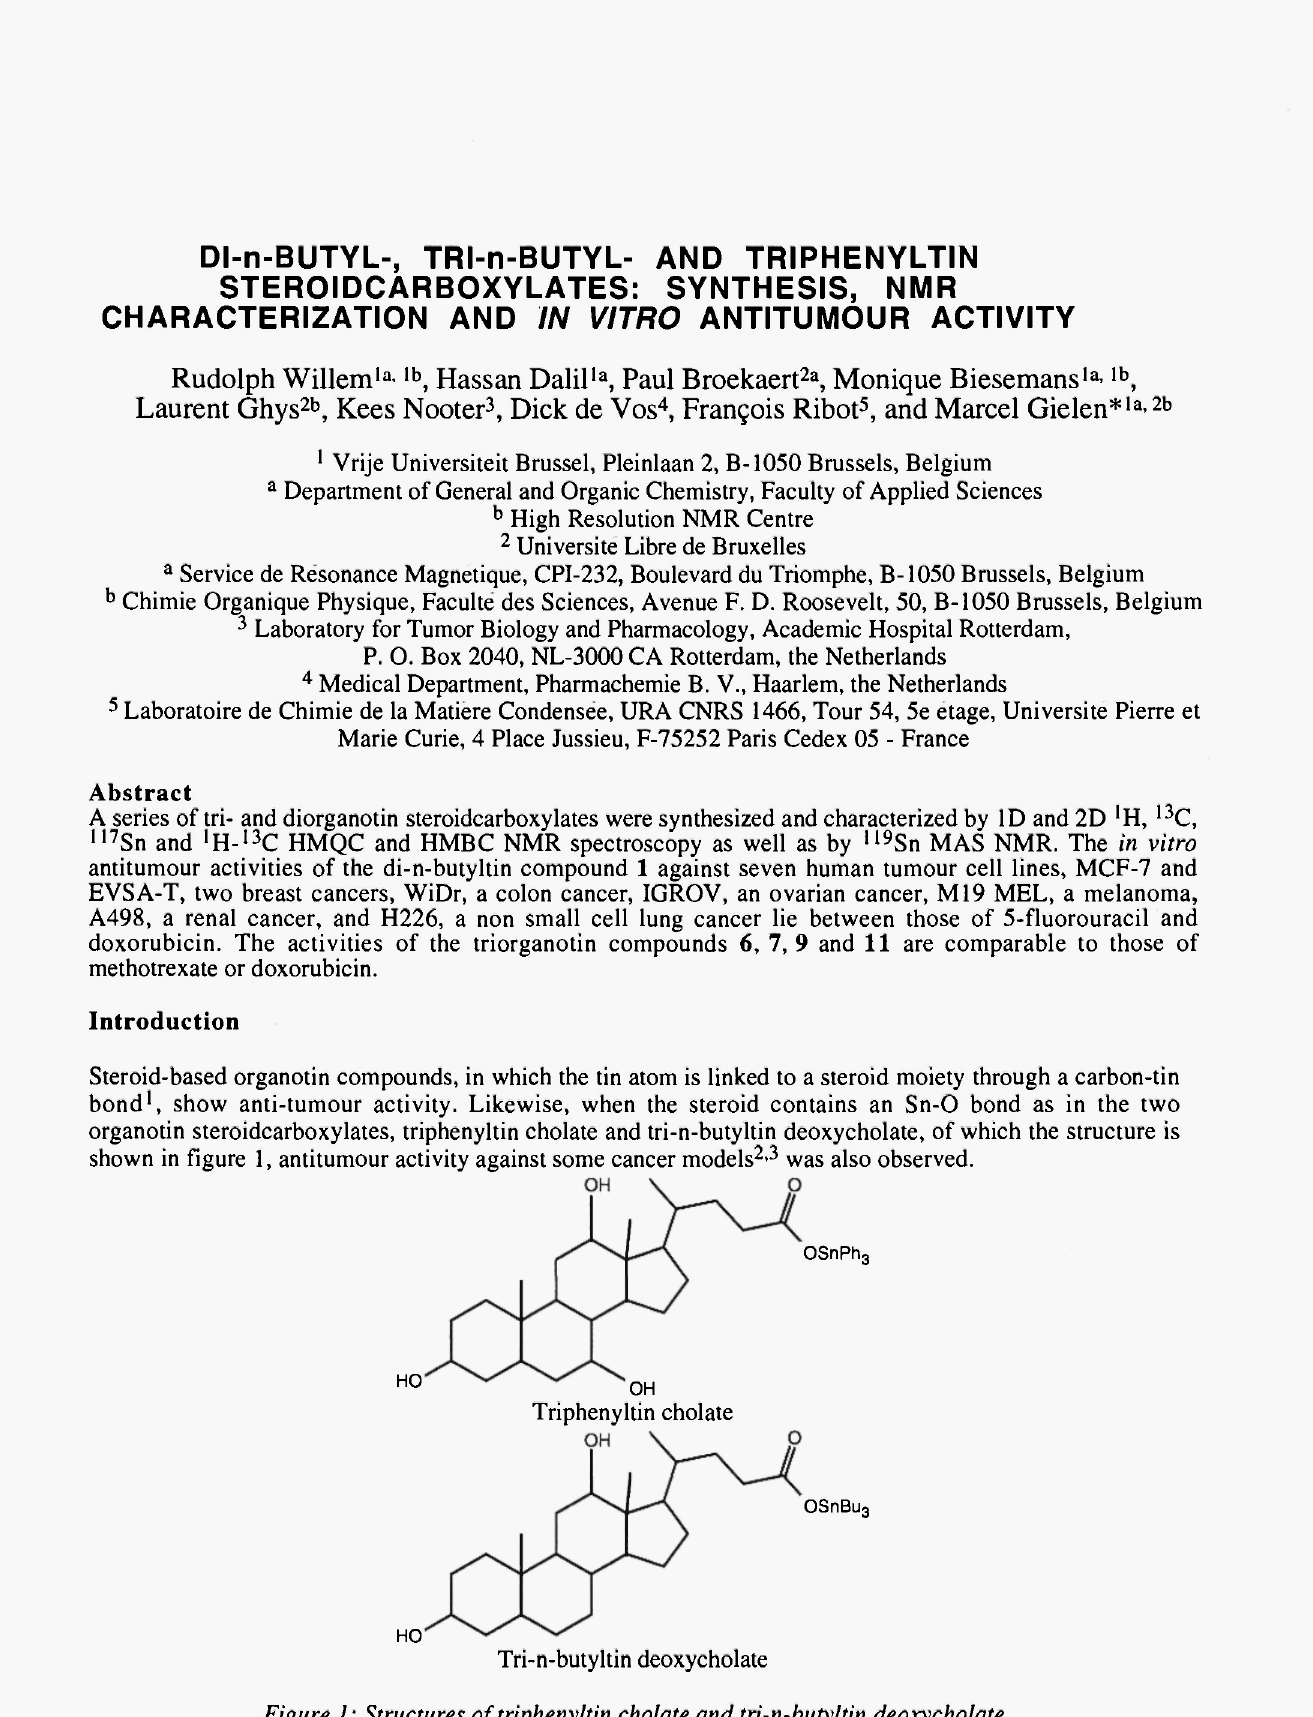
Figure 1: Structures of triphenyltin cholate and